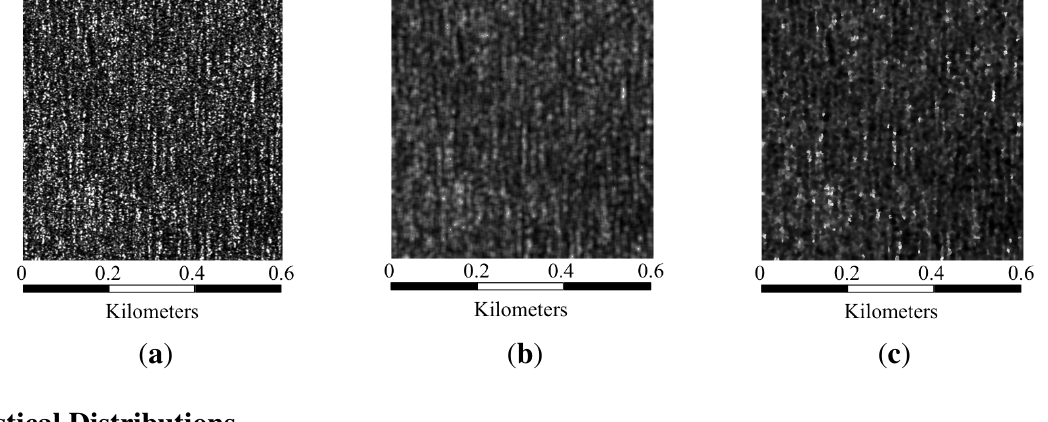
Figure 6. Comparison of the original Patch 1 and the best filtered results. ( a ) Patch 1; ( b ) Patch 1 filtered with sigma, σ = 0 . 9 and T h = 4 and h = 0 . 5 s r